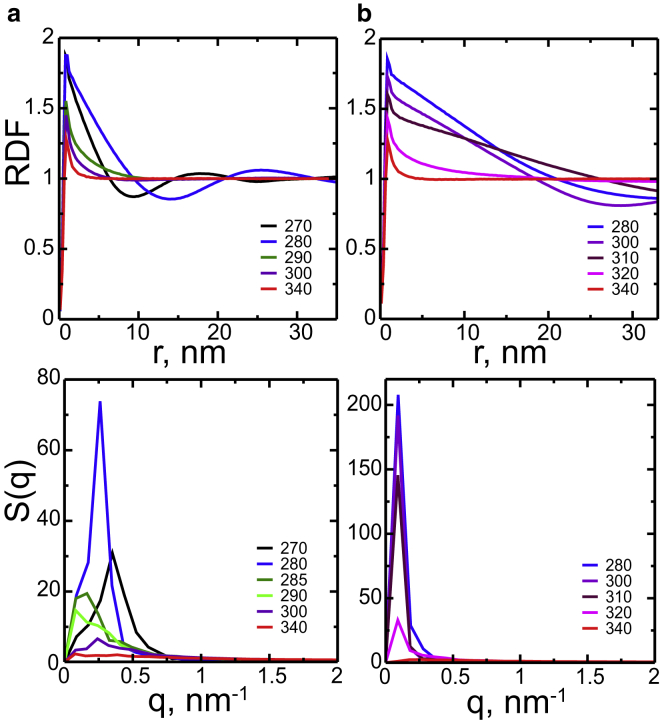
Lateral structure of the bilayers: 2D RDFs (top panel) and 2D structure factors (bottom panel), for the DPPC/DUPC 3:2 (a) and DPPC/DUPC/cholesterol 7:7:6 (b) large bilayers at different temperatures (K) are shown. RDFs and structure factors are calculated for the COMs of DUPC in the same leaflet. To see this figure in color, go online.